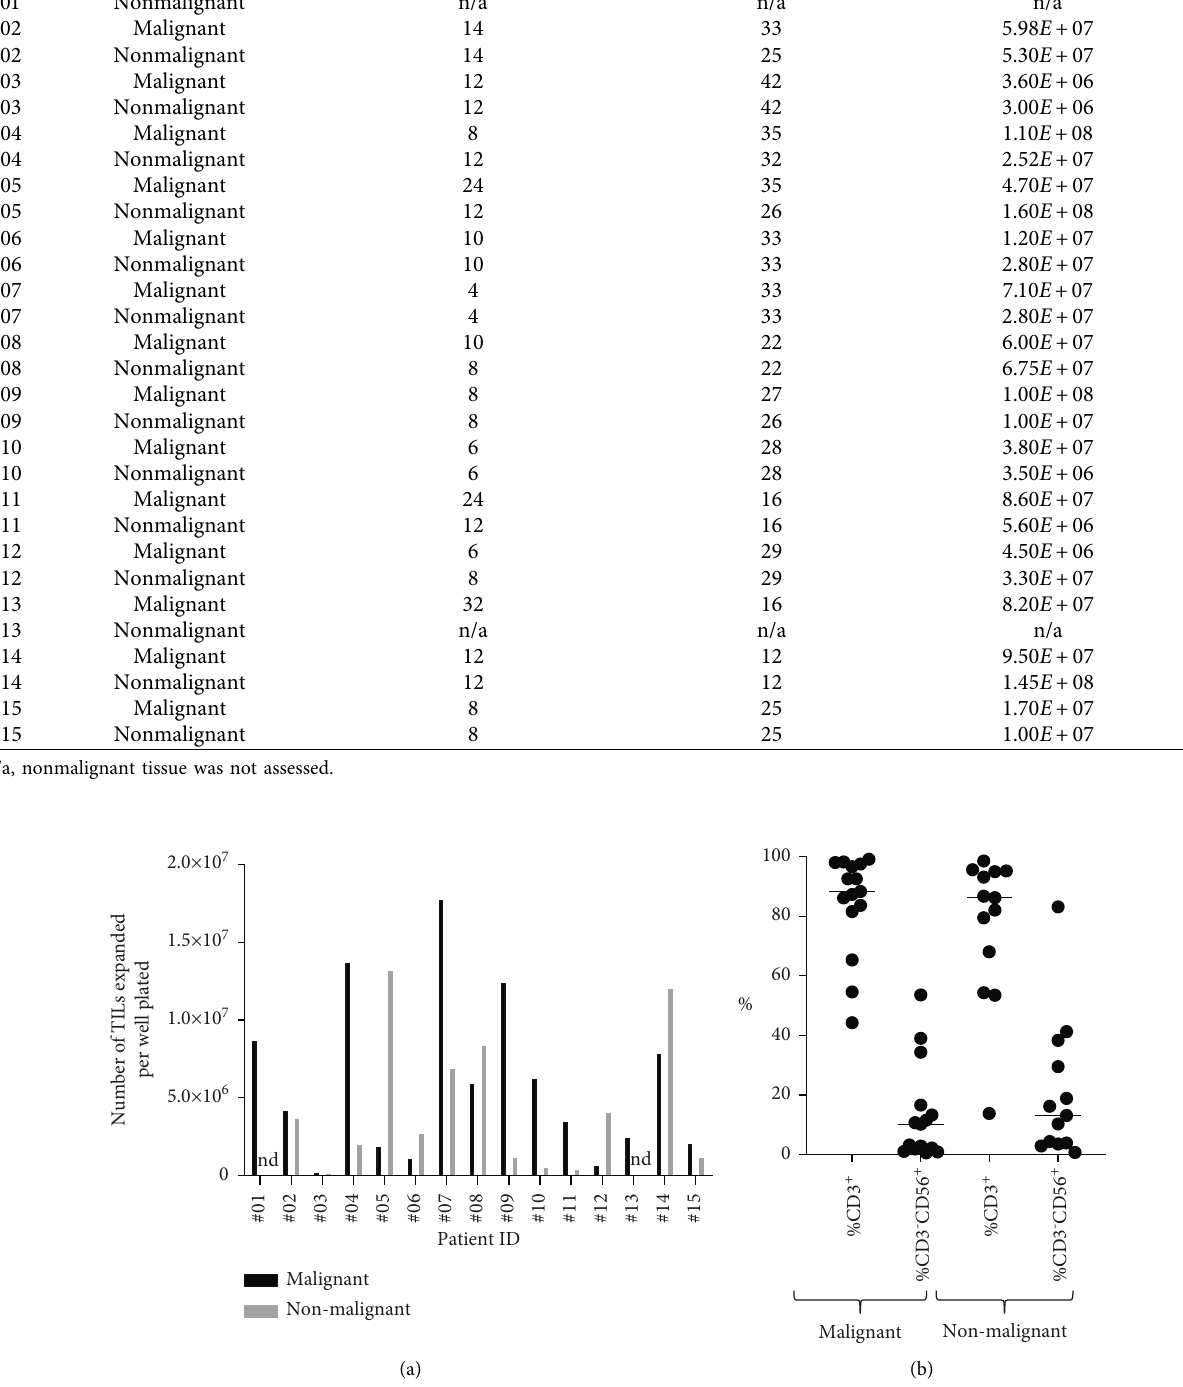
Figure 1: Properties of TIL cultures. (a) The number of TILs expanded from malignant and adjacent nonmalignant tissues is shown. Numbers of TILs are normalized to one starting well for each tissue sample. nd, not done. (b) The proportion of CD3 + T cells and CD3 − CD56 + cells were quantified by flow cytometry at the time of TIL culture